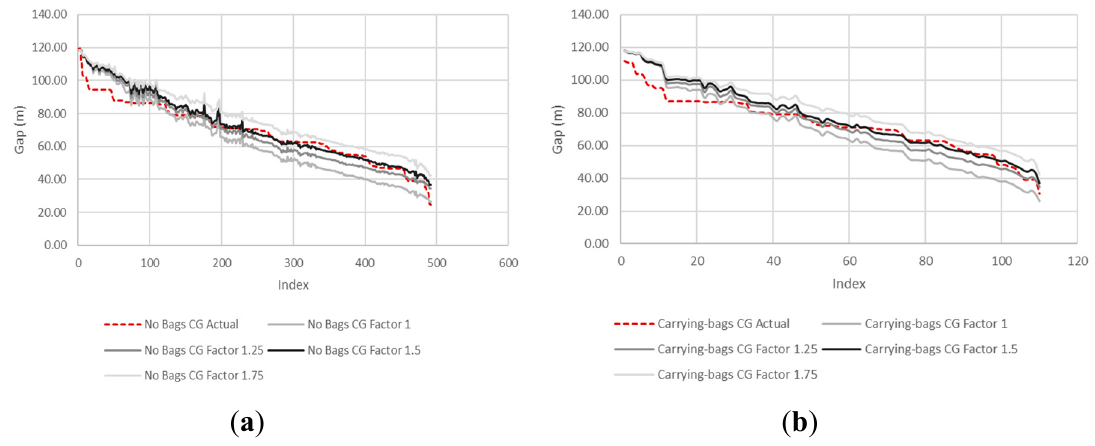
Figure 8. Comparison between actual data and simulation results per presence of bags. ( a ) Not carrying bags; ( b ) carrying